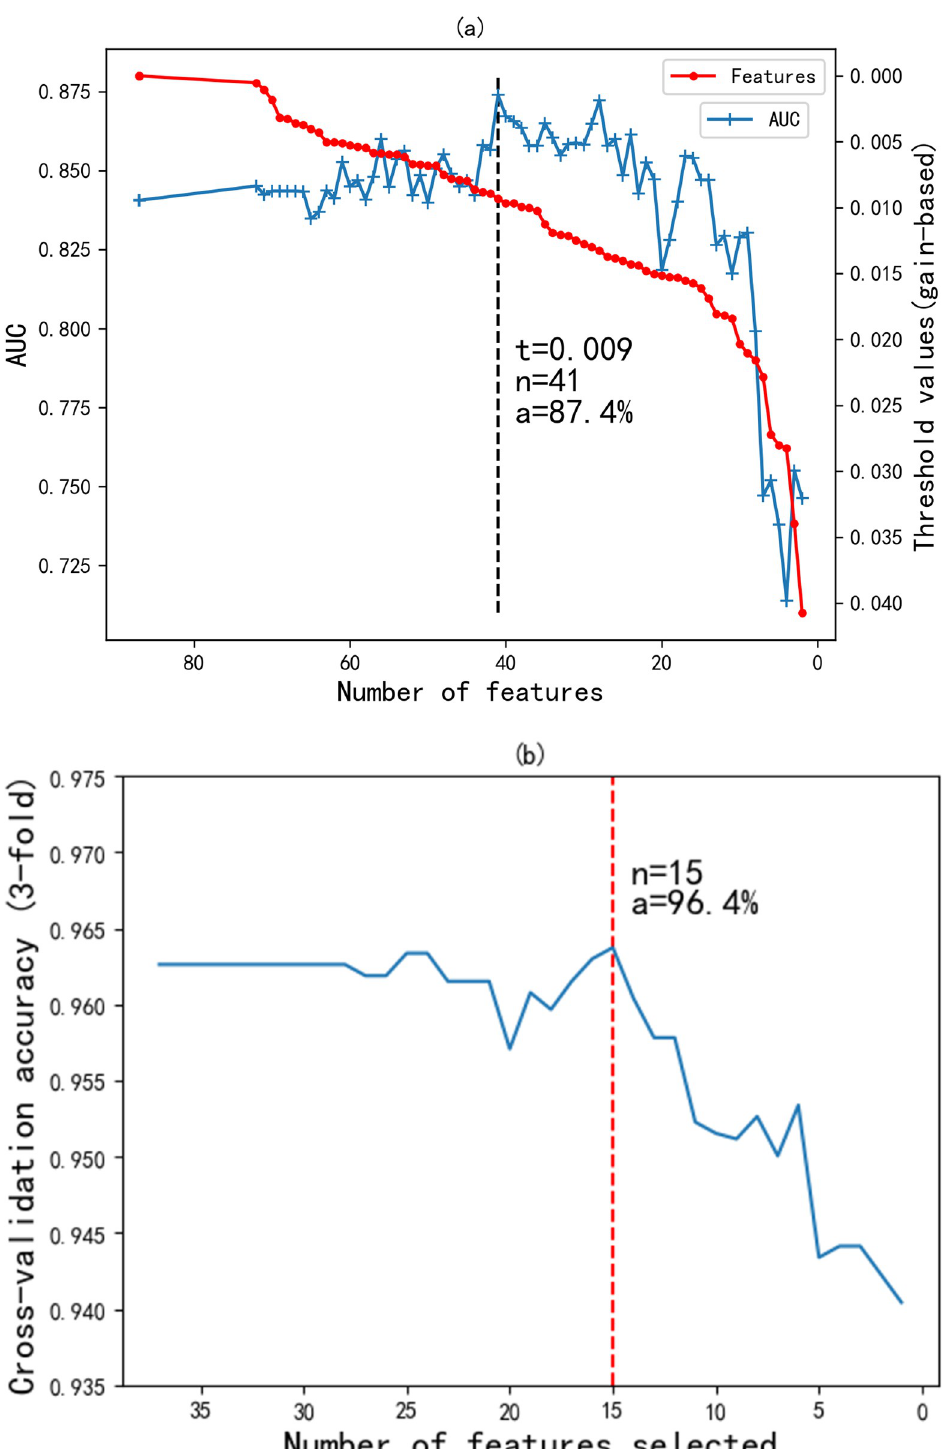
Fig 4. Hybrid feature selection. (a) feature filtering by relative importance ranking; (b) feature combination selection by RFECV.